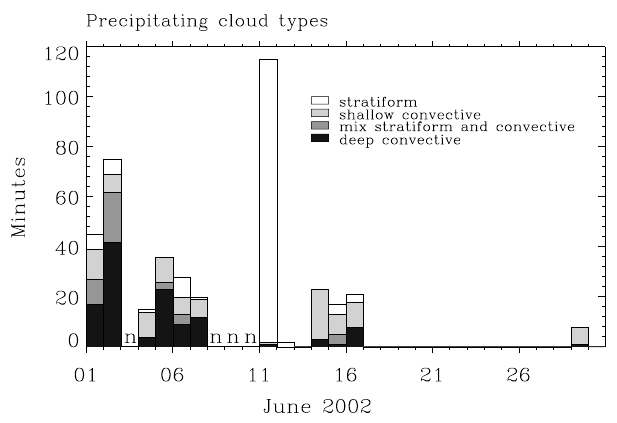
Fig. 14. Time variation of precipitating cloud types classified by BLR in June 2002. “n” at the bottom indicates no data through one